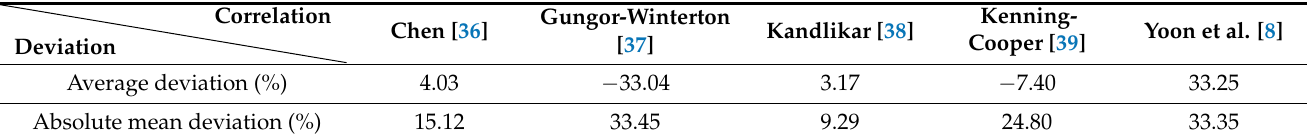
Table 8. Comparison of deviation between the calculated and experimental heat transfer coefficient for all data prior to